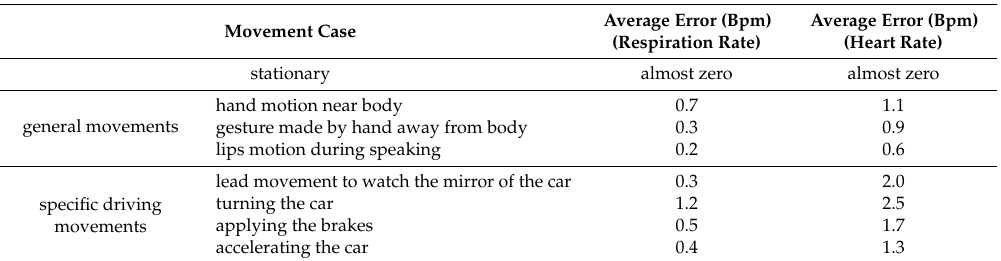
Table 3. Average error for respiration and heart rate of different human subjects (five humans).